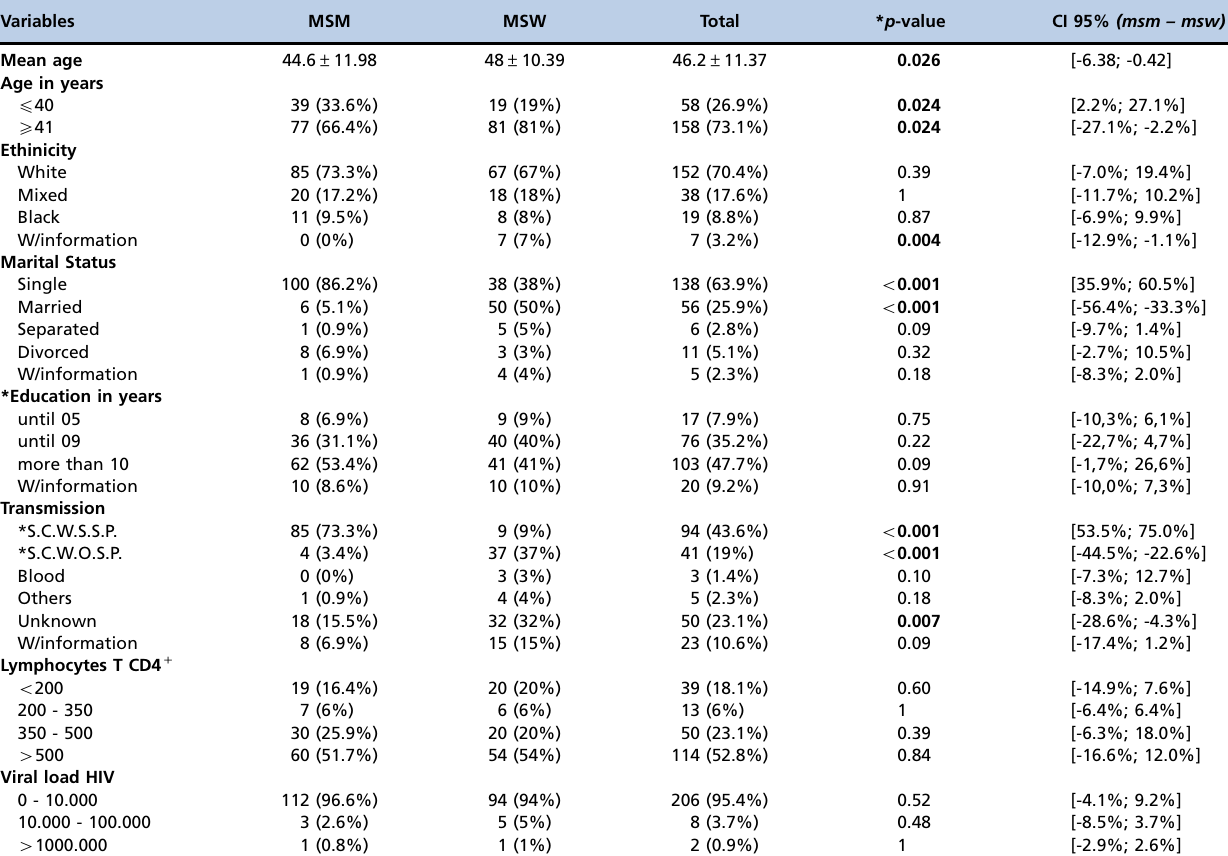
Table 1 - Demographic data from 216 patients infected by